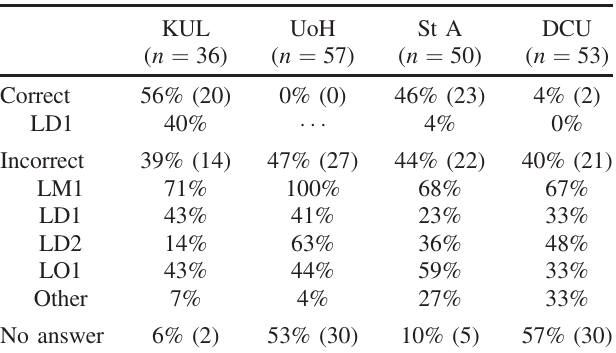
TABLE IV. Summary of responses to question 1(b) [Fig. 1(a)]. Incorrect responses are associated with the errors listed in Table I. Since students can exhibit multiple difficulties in a single sketch, the percentages do not sum to 100.